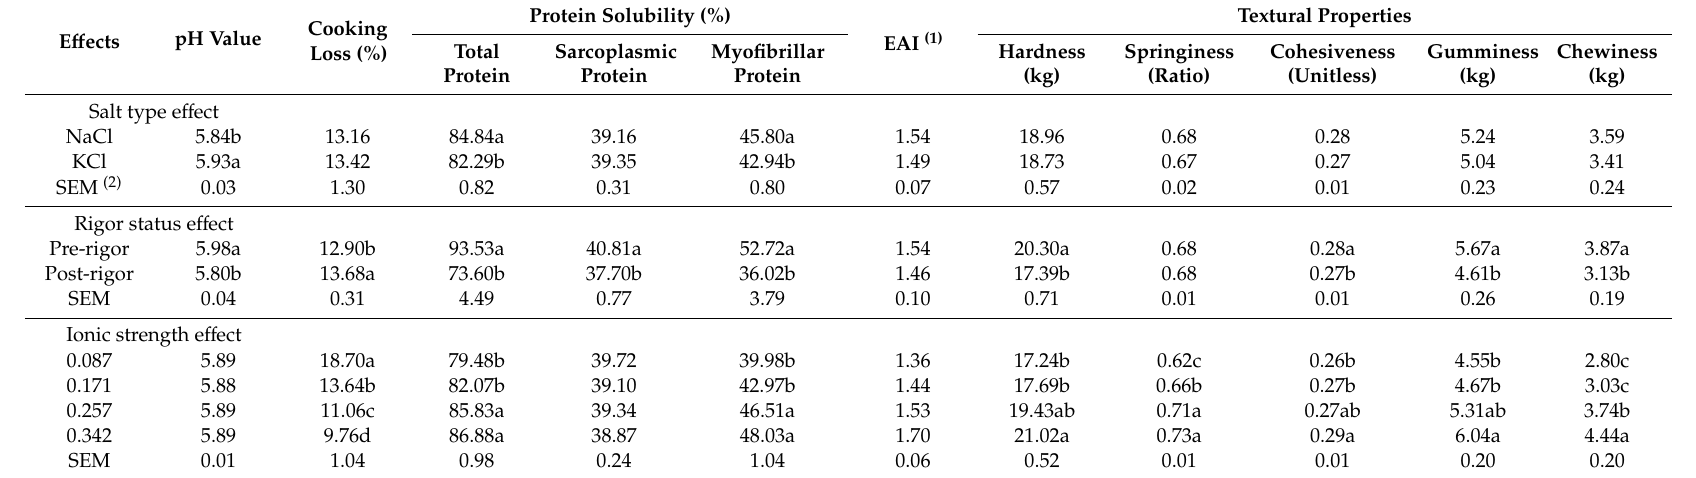
Table 3. E ff ects of salt type, rigor status, and ionic strength on technological properties of salted chicken